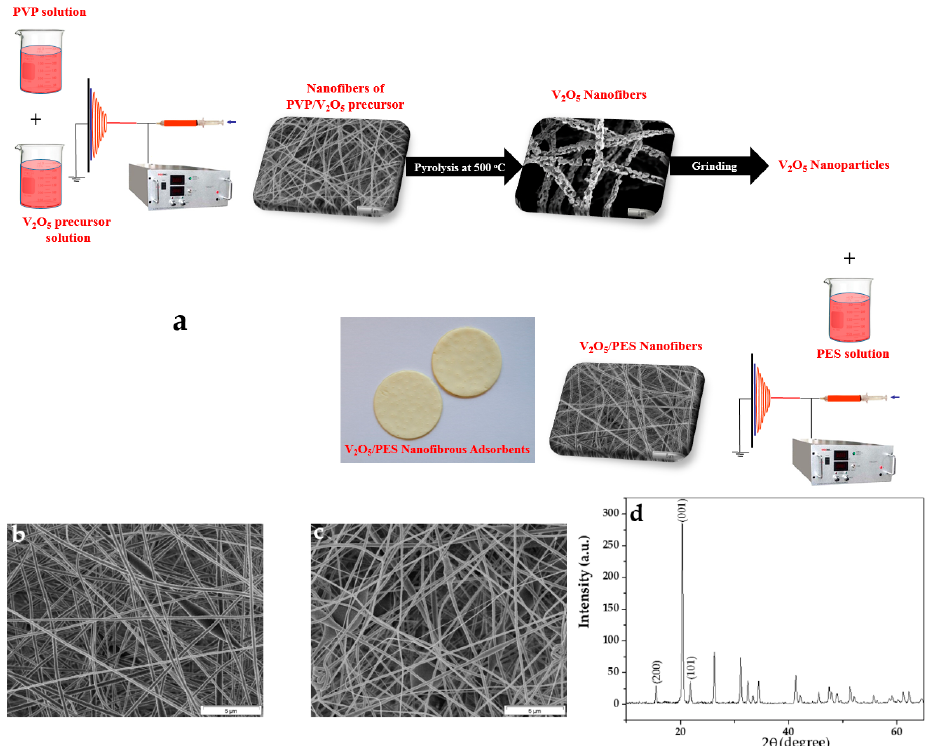
Figure 1. ( a ) Schematic of preparation procedure of the vanadium pentoxide/polyethersulfone (V 2 O 5 /PES) nanofibrous adsorbents; Morphology of the nanofibers of: ( b ) PES and ( c ) 5 wt % V 2 O 5 /PES; and ( d ) X-ray diffraction (XRD) pattern of the V 2 O 5 nanoparticles after calcination at 500 °C. PVP: polyvinylpyrrolidone.